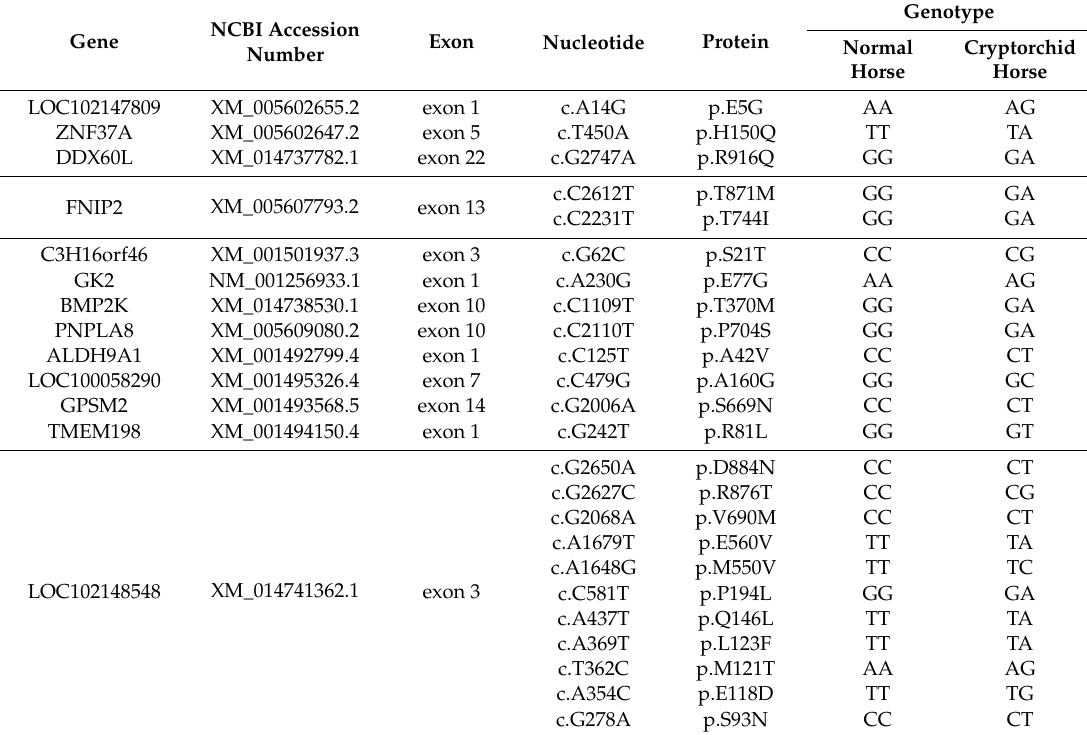
Table 2. Candidate SNPs associated with cryptorchidism.